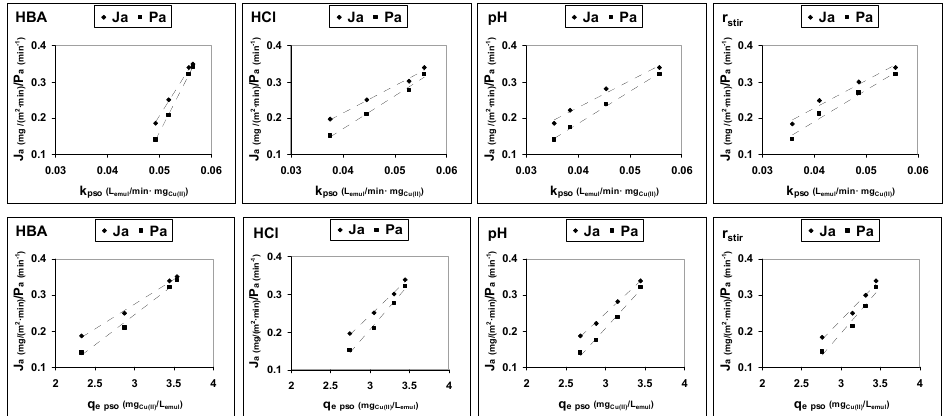
Figure 6. Relationship between the values of pseudo ‐ second ‐ order model parameters (k pso and q e,pso ) and the experimental initial apparent fluxes (Ja) and permeabilities (Pa).